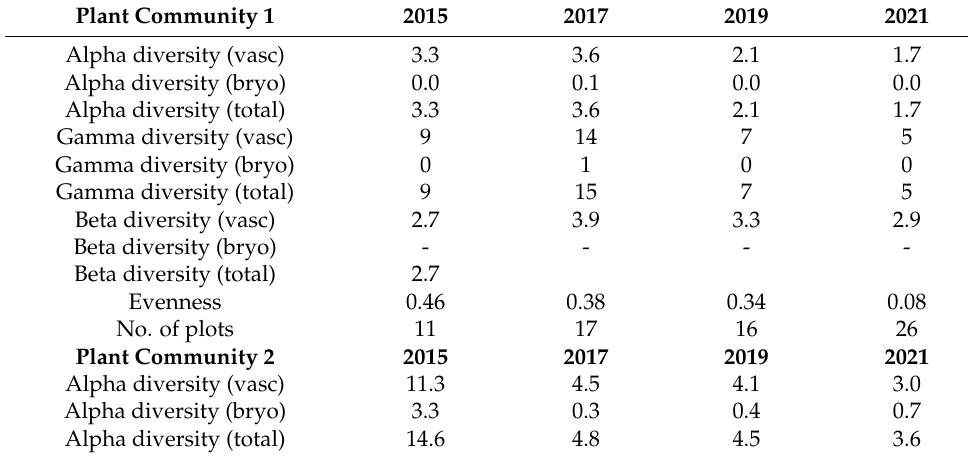
Table 1. Species richness parameters for the three Plant Communities and the group of 3–5 outlier plots (Group 4) for the four years—2015, 2017, 2019, and 2021. Vasc = vascular plants, bryo =